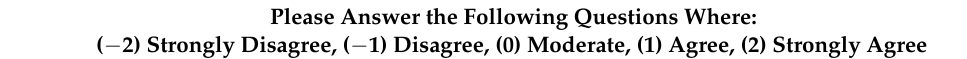
Table 10. Evaluation questionnaire for the MedChemVR